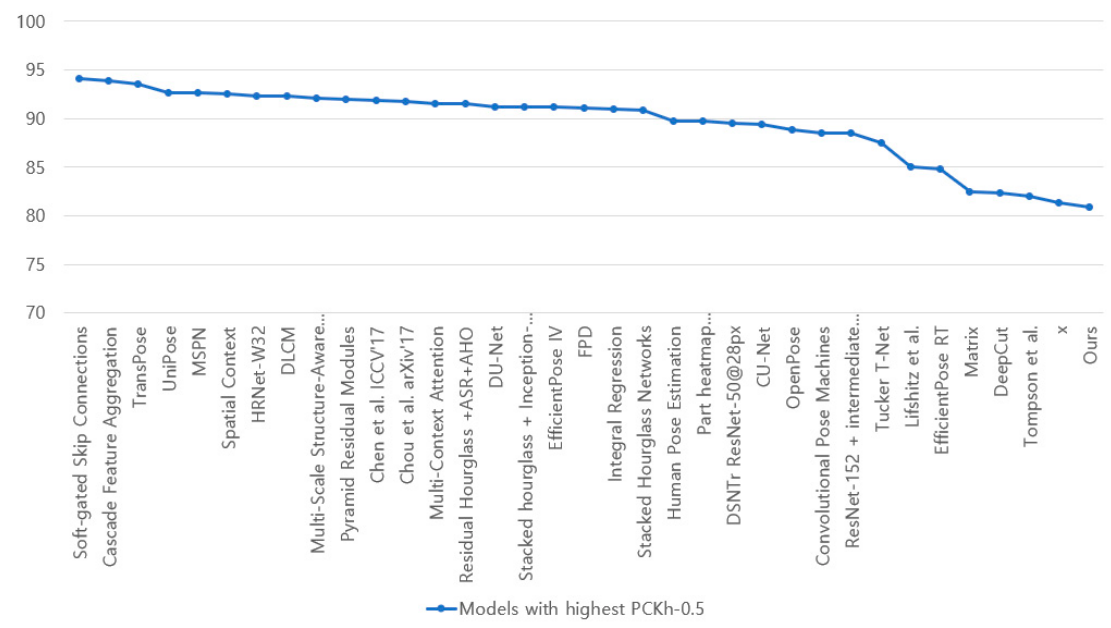
Figure 3. Accuracy by deep learning model using MPII human pose dataset [30].